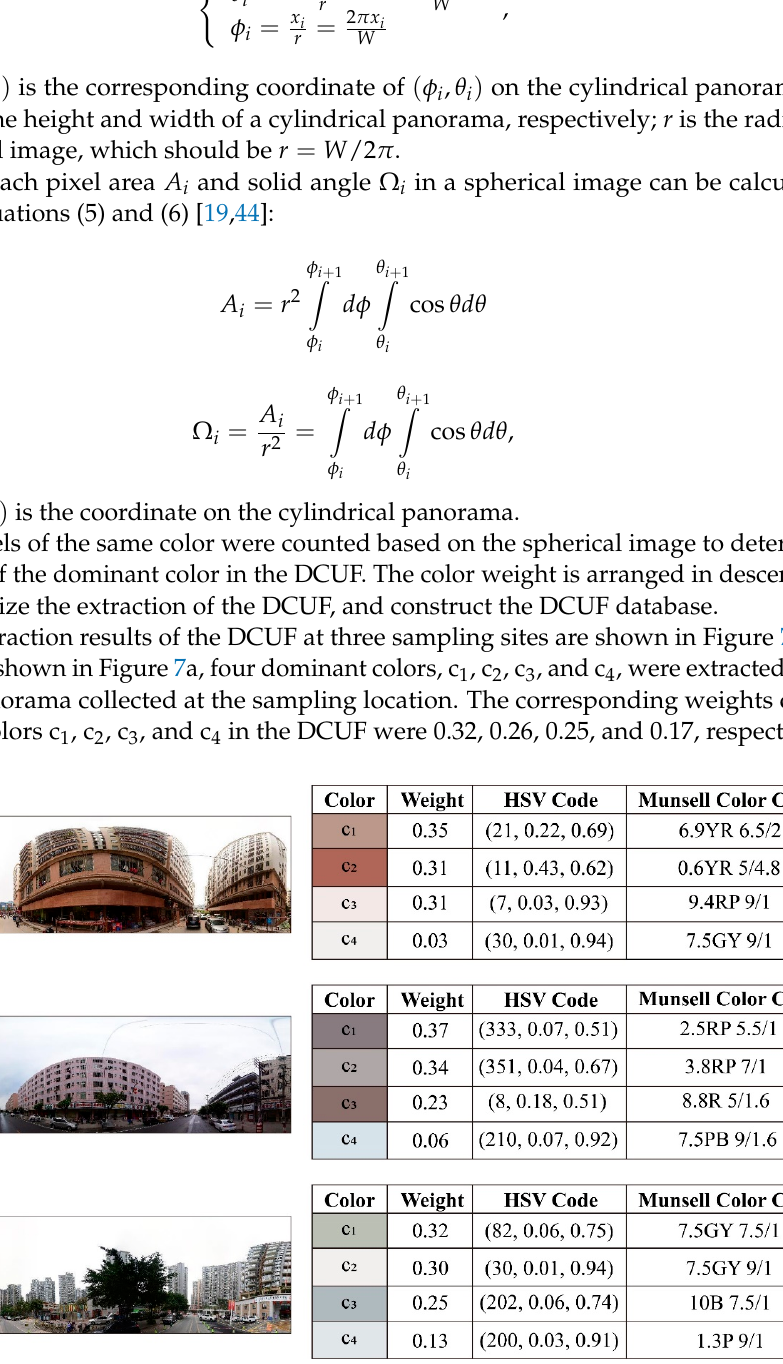
Figure 7. The extraction result of DCUF of three sample BSV panoramas. ( a ) An illustration of the BSV panorama and the corresponding four dominant colors in the DCUF, ( b ) the extraction results of four dominant colors in the DCUF at another sampling site, ( c ) the illustration of the four dominant colors in the DCUF at the third sampling site.